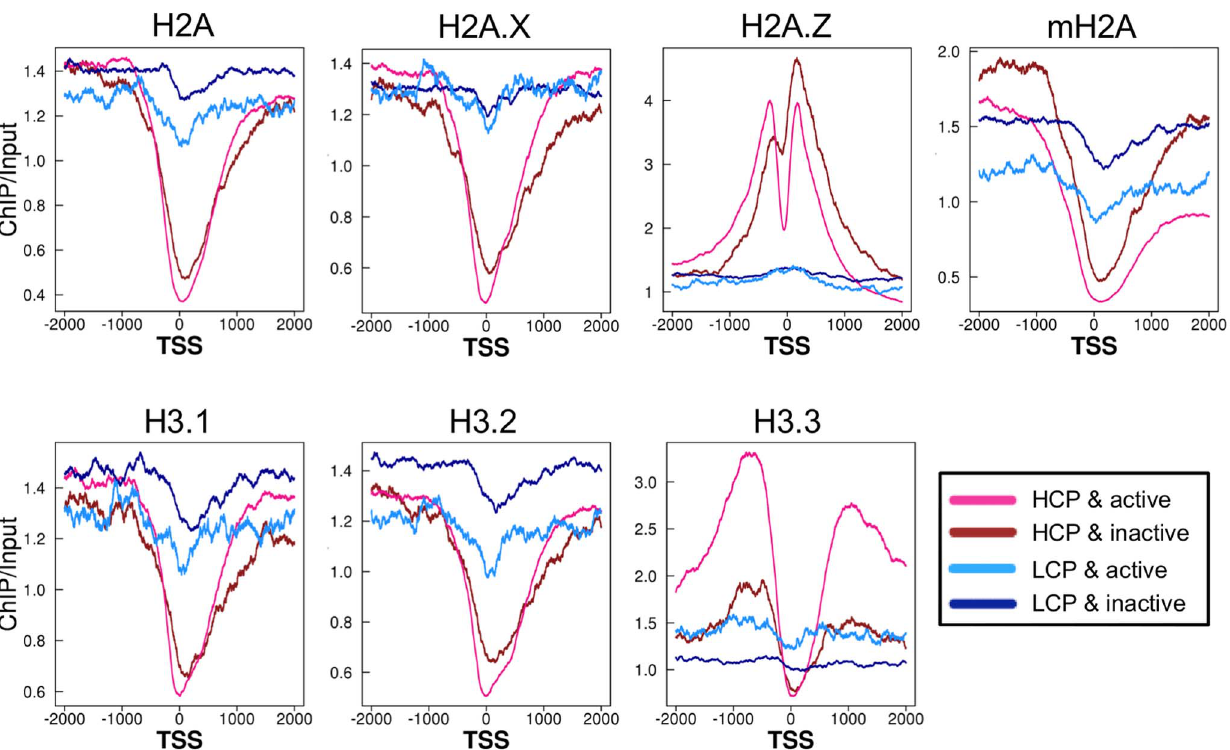
Figure 2. Enrichment of histone variants around the TSS with promoters of high and low CpG density. Line graphs show average enrichment of histone variants around the TSS of HCP & active, HCP & inactive, LCP & active and LCP & inactive